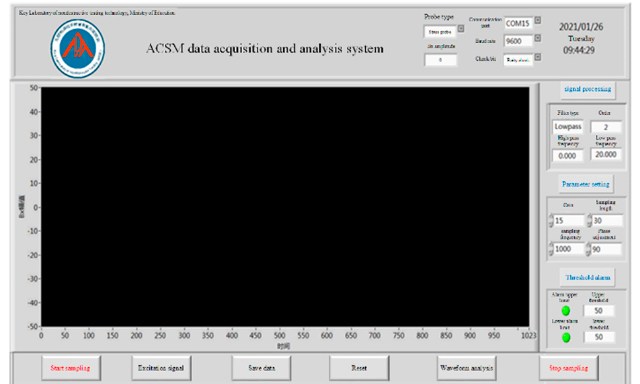
Figure 17. The host computer interface of ACSM stress measurement system.